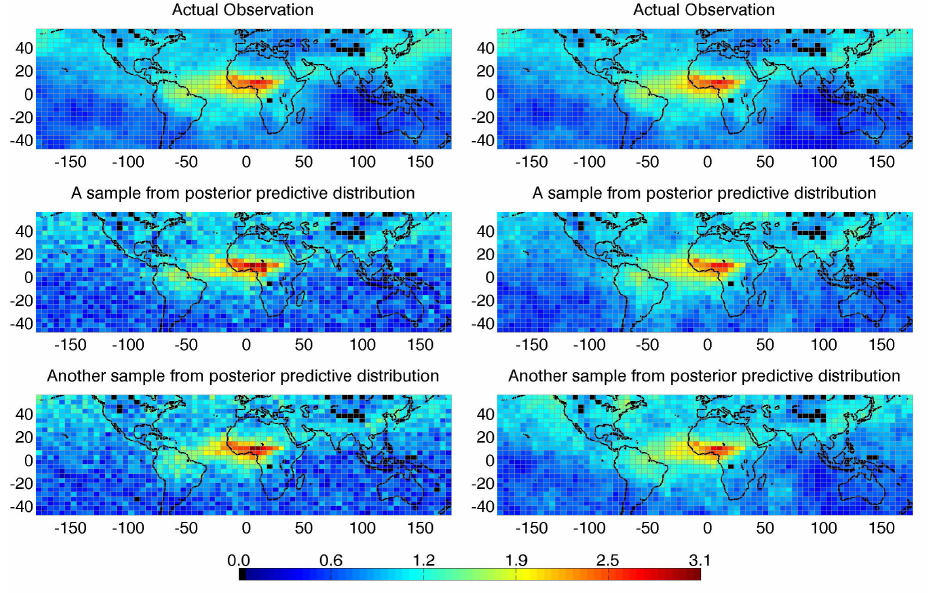
Fig. 11. Posterior predictive plots as in Fig. 10, now with L =